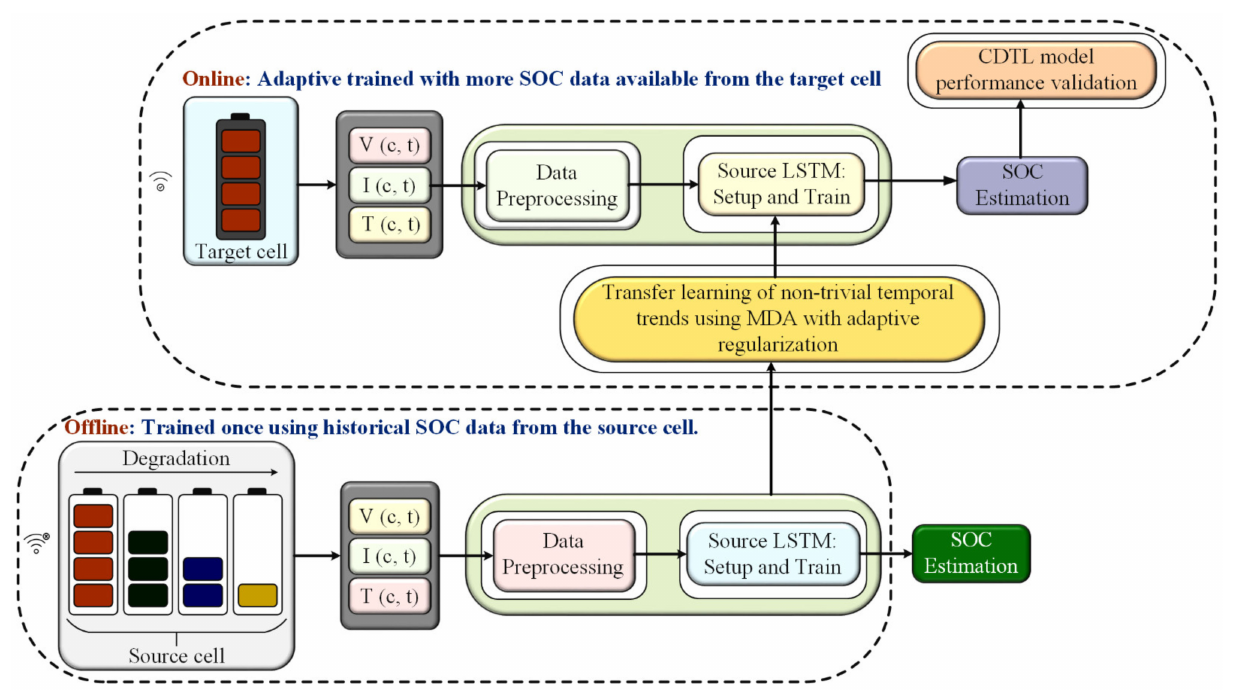
Figure 5. Improved LSTM model-based SOC estimation